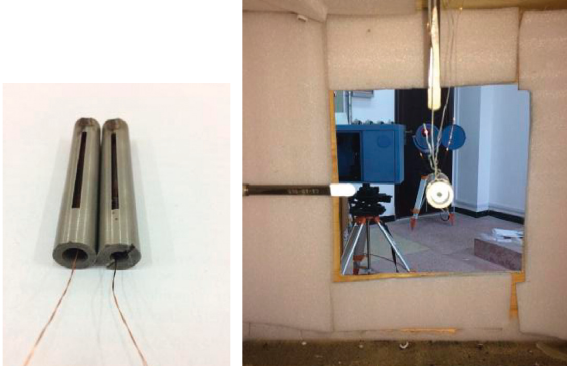
Figure 3: Cutting seam cartridge used in tests with high-speed schlieren